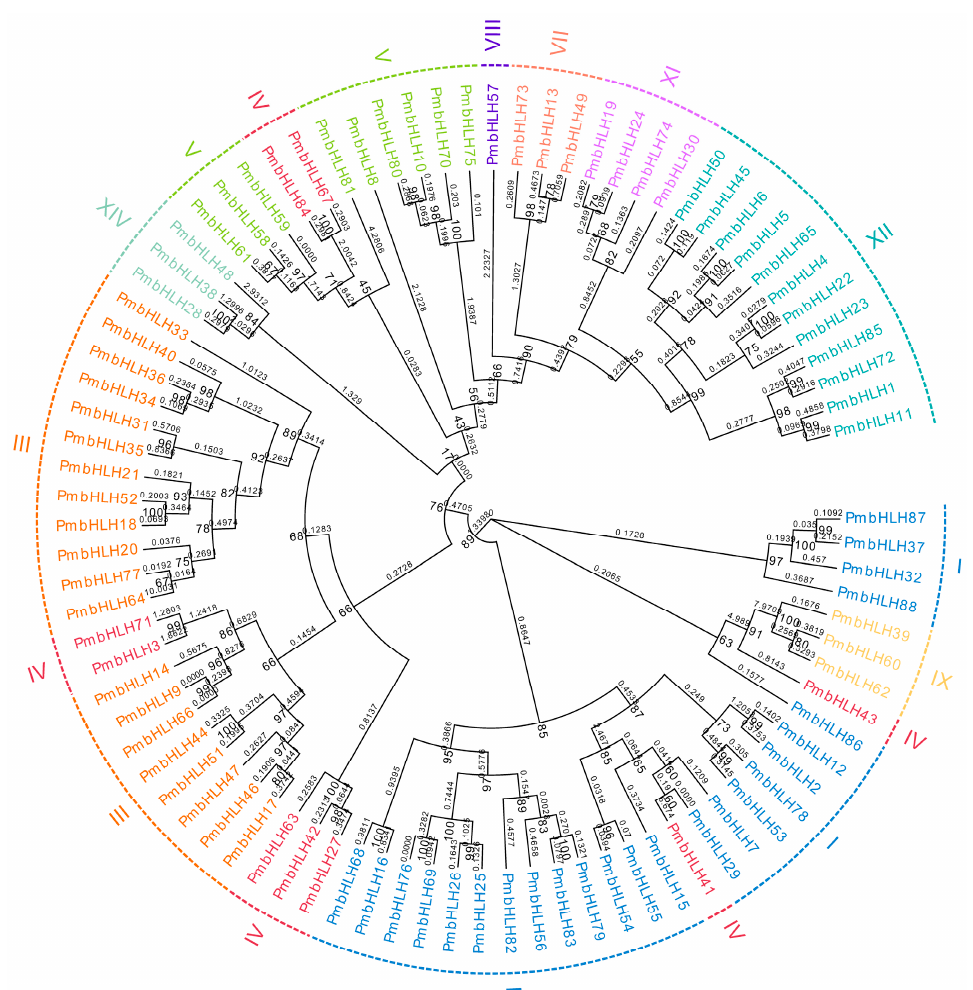
Figure 1. Phylogenetic analysis of bHLH proteins in P. massoniana . Gene names in different colors correspond to groups of the same color in the outermost circle, and the numbers on the node in the figure indicate branch support values. The decimals on the branches represent the different lengths of the branches, indicating the differences between the proteins.